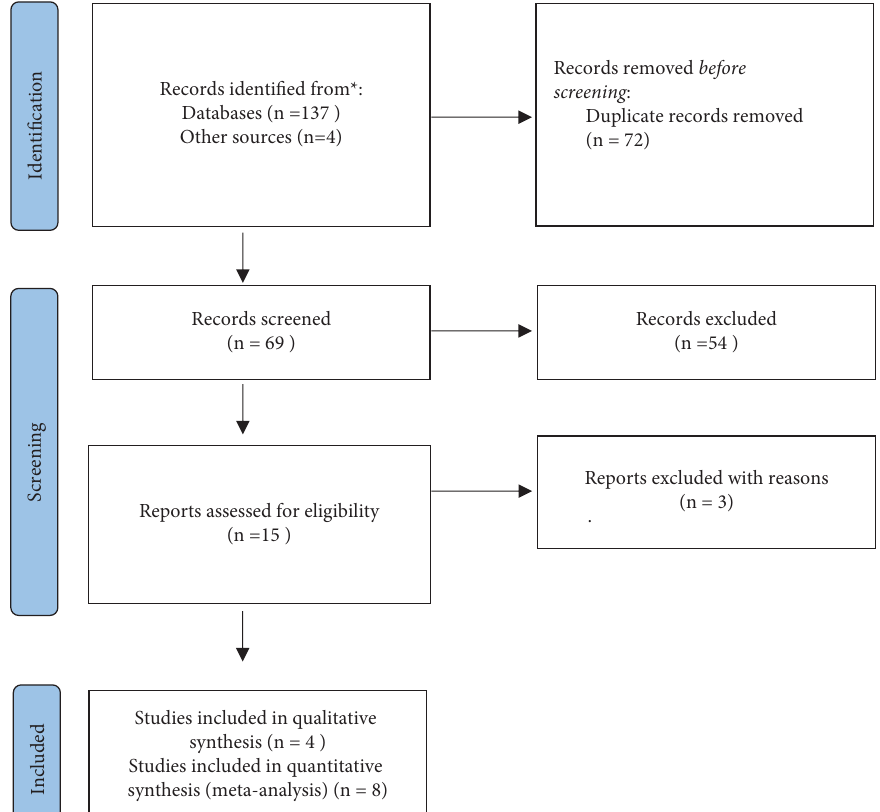
Figure 1: PRISMA fow diagram of the study selection and identifcation process. PRISMA, Preferred Reporting Items for Systematic Reviews and